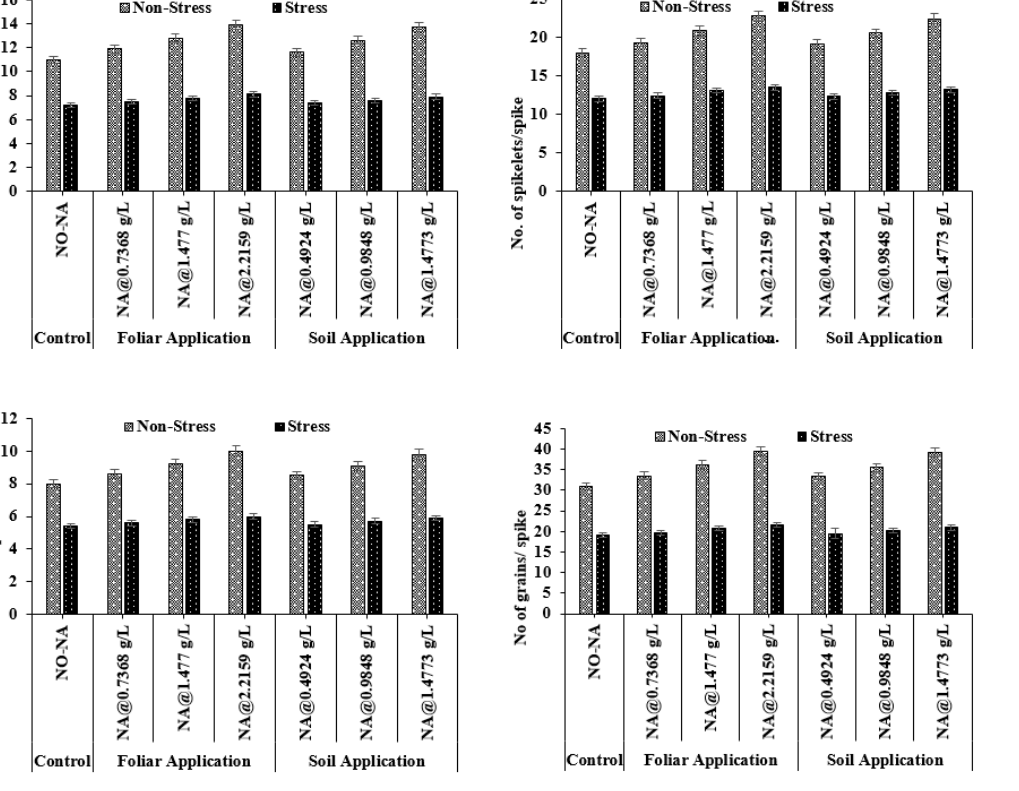
Figure 2. Effect of exogenously applied nicotinic acid on spike length (cm), spikes count per plant, tiller count per plant, and number of grains at anthesis stage of the plant under control and water deficit stress levels.